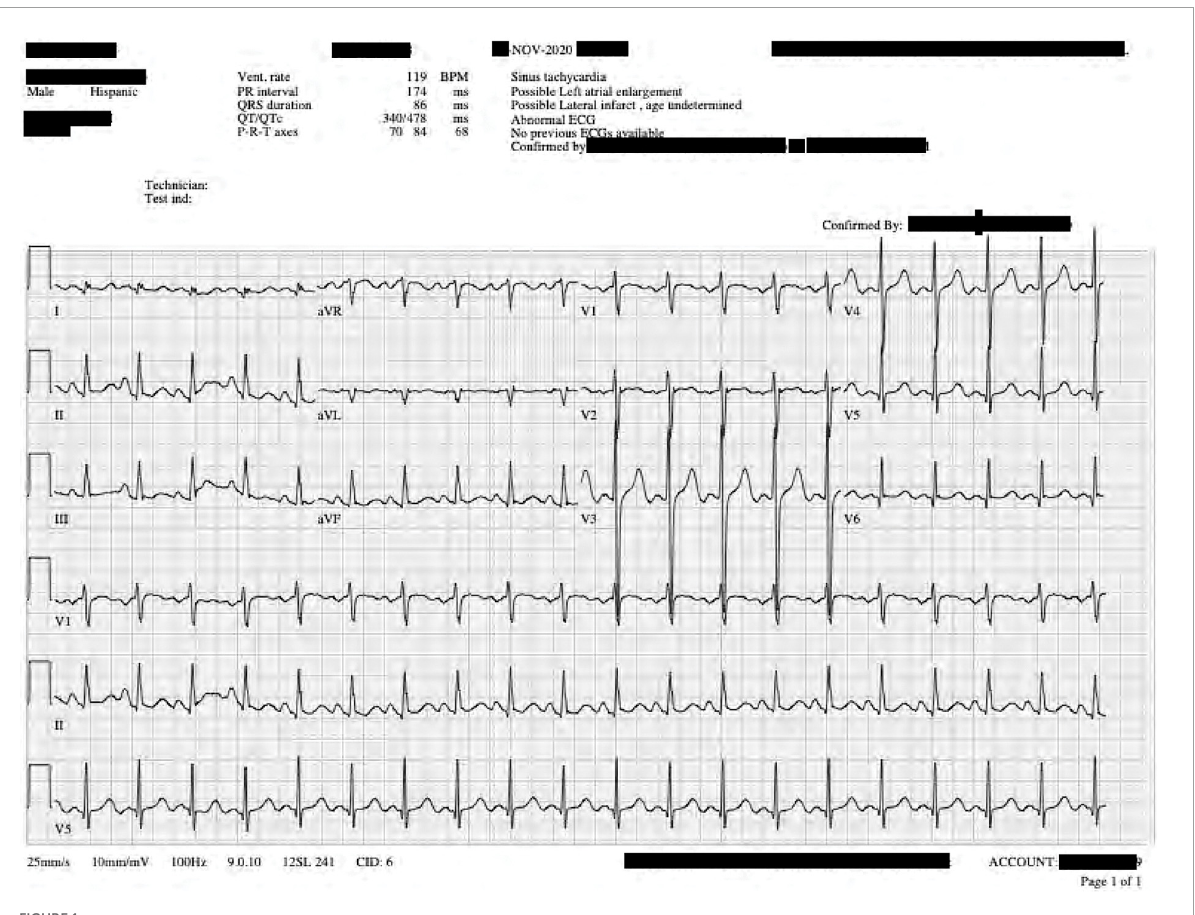
FIGURE1 Twelve-lead electrocardiogram taken during the patient’s current presentation shortly after stabilization. T wave elevations are noted in leads II, V5–V6.